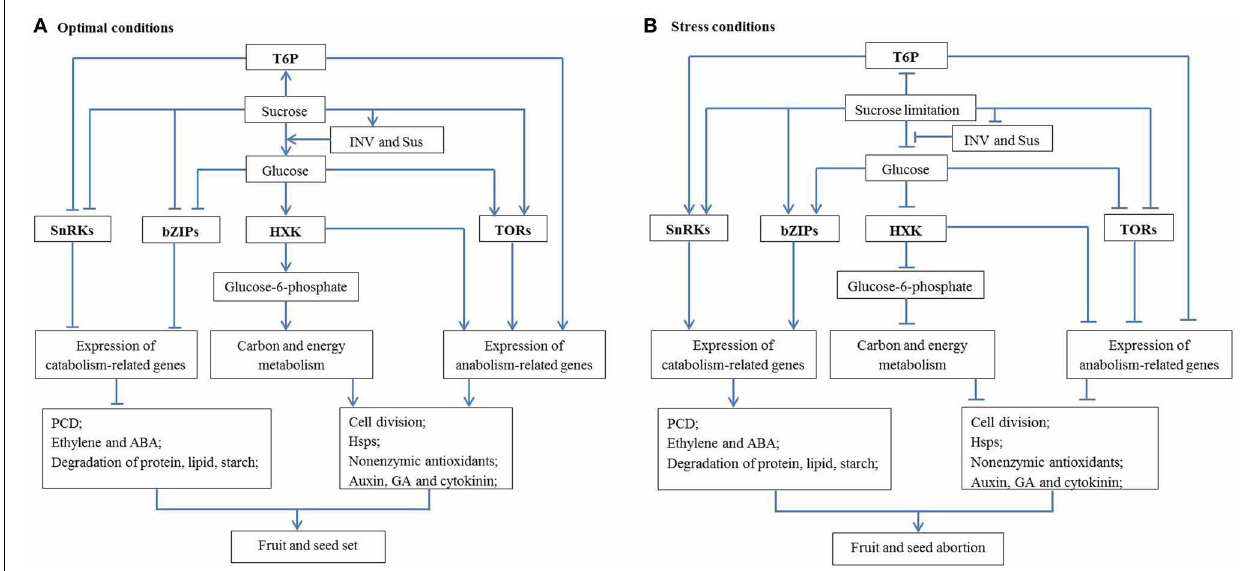
FIGURE 1 | A schematic network illustrating the mechanisms by which sugar metabolism and signaling regulate fruit and seed set under abiotic stresses. (A) Under optimal conditions with high sucrose availability, INV and Sus activities generate sufficient amount of hexoses (glucose) to activate cell division; to facilitate the production of non-enzymatic antioxidants and to inhibit PCD. On the other hand, T6P promotes biosynthetic process and represses the activity of a growth inhibitor, SnRKs. These features interact with hormonal signaling pathways